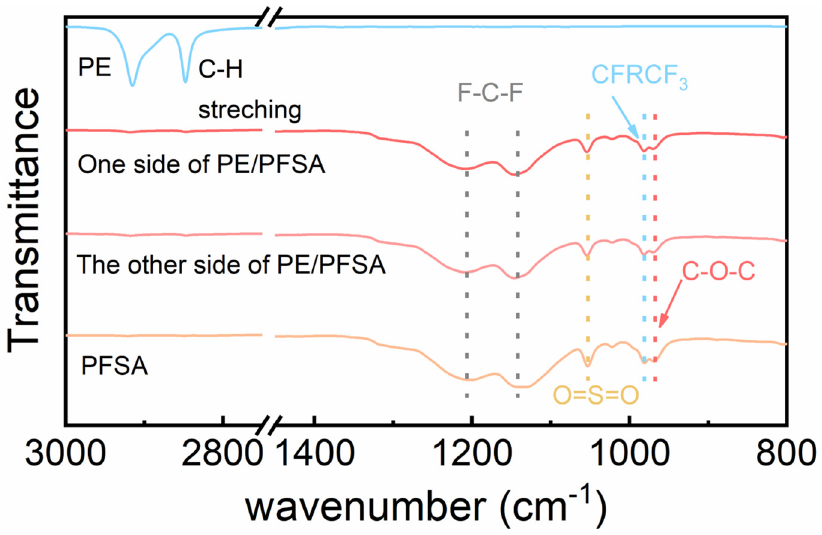
Figure 3. FTIR spectra of the PE, pure PFSA, and both sides of the PE/PFSA membrane. The physicochemical properties, including ion exchange capacity (IEC) and dimen- sional and mechanical stability, are important reference parameters of the membrane. As shown in Table S1, the IEC value of PE/PFSA (0.29 mmol g − 1 ) was lower than those of Nafion212 (0.95 mmol g − 1 ) and pure PFSA (0.90 mmol g − 1 ). This was due to the